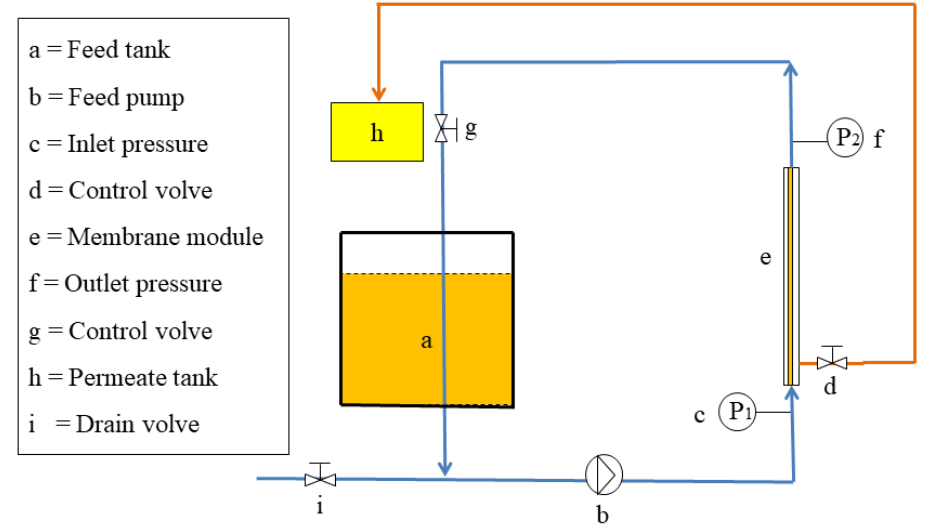
Figure 1. Experimental device of the ceramic membrane system.